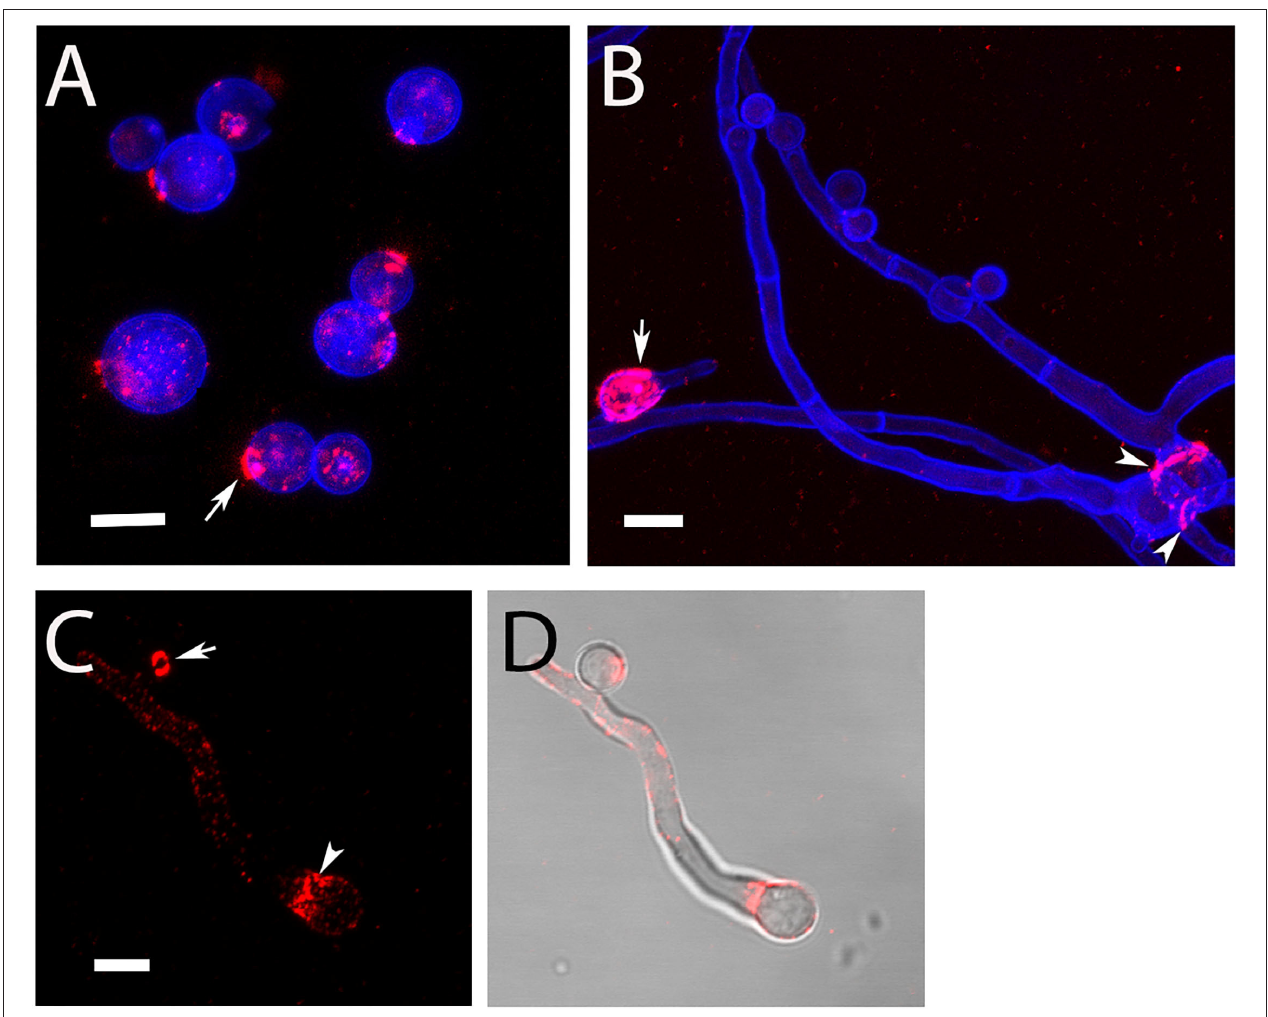
FIGURE 1 | Detection of surface-accessible β -glucan on AC and hyphae of strain At17-14. β -Glucan was stained using mab 2G8 (red). The fungal cell wall was additionally visualized with the chitin-specific dye Calcofluor white (blue). Arrows in (A,C) indicate ring-like, β -glucan-positive structures. The arrow in (B) points a conidial body with a patchy staining of the entire surface. The arrowheads in (B,C) indicate a collar-like pattern of β -glucan in the proximal part of the emerging germ tube. (D) Shows an overlay of the galactomannan staining shown in (C) and a bright field image. Bars in (A–C) represent 5 µ